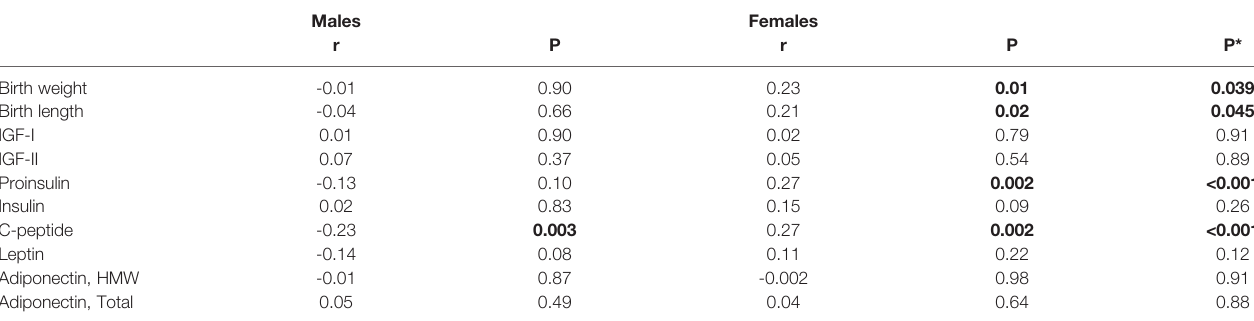
TABLE 2 | Cord blood FGF19 in correlations with birth weight, birth length, fetal growth factors, leptin and adiponectin in males and females. Males Females r P Birth